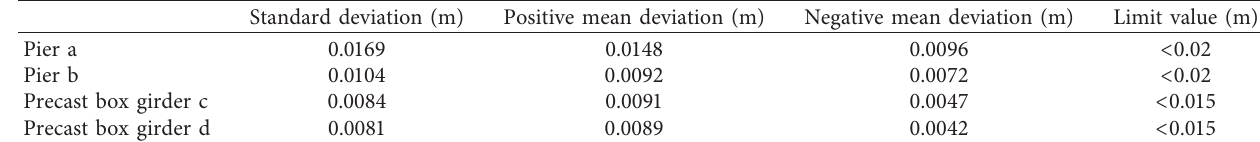
Table 1: Comparison results of the reconstruction of BIM l and the point